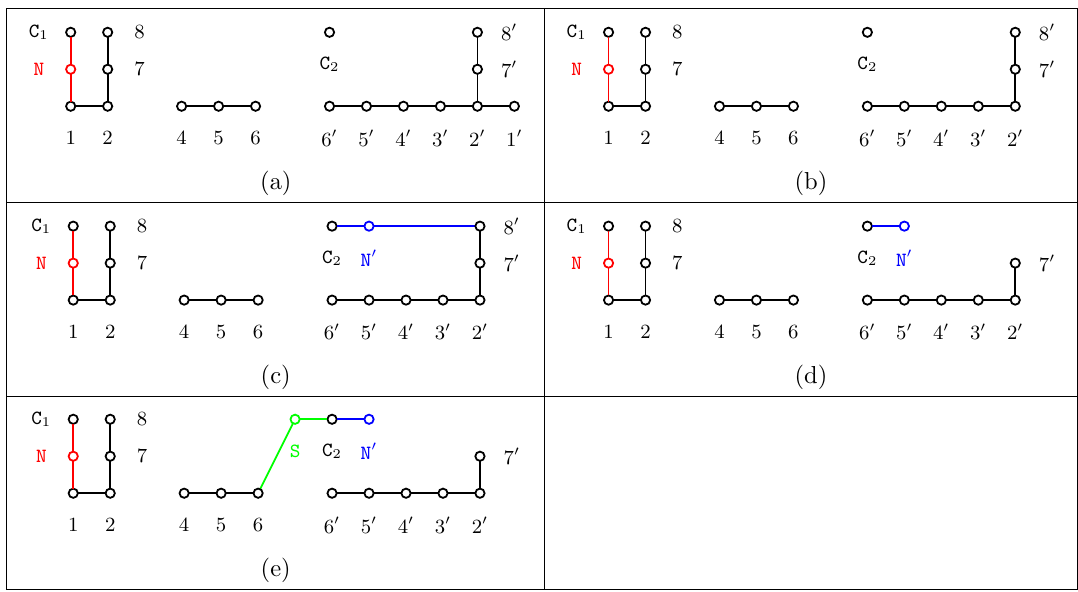
Figure 17. Dynkin diagrams for the steps leading to the enhancements A 3 + A 6 + A 9 (c) and 3A 6 (e), starting from a point with A 6 + A 3 + A 1 + E 8 (a). Intermediate stages where the symmetry is broken are shown in (b) and